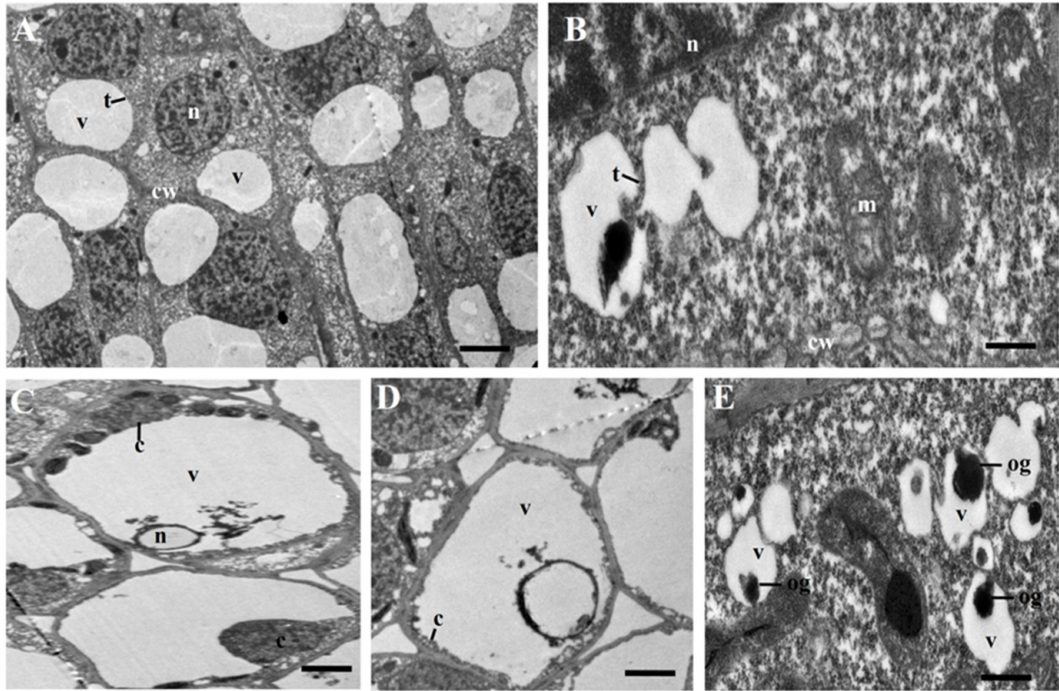
Figure 6. Transmission electron microscopy (TEM) micrographs of tobacco flower buds. ( A ) ZY. ( B – E ) msZY. v: vacuole, n: nucleus, t: tonoplast, cw: cell wall, c: cytoplasmic, m: mitochondria, og: osmophilic granules. Scale bars in ( A ) = 5 µ m, in ( C , D ) = 3 µ m, and in ( B , E ) = 1 µ